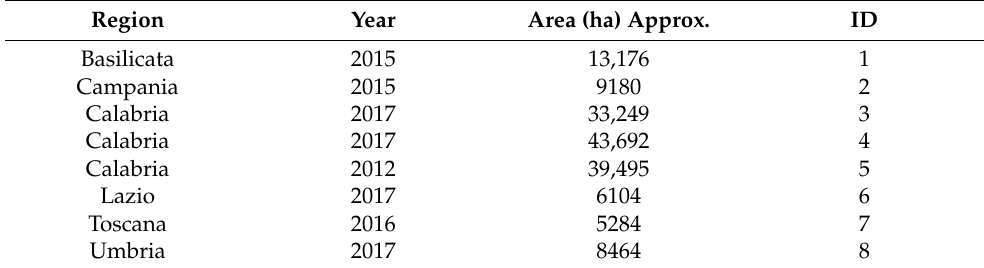
Table 1. Summary table of wildfire events considered as case studies. Region Year Area (ha) Approx.